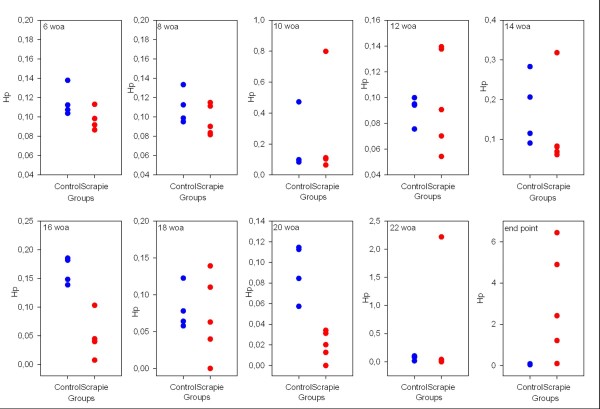
Comparison of difference in Hp levels in serum between healthy controls and scrapie infected sheep from six to 23/24 weeks of age. Scrapie (red dots), controls (blue dots), haptoglobin (Hp) levels measured in mg/ml indicated on y-axis and groups are presented on the x-axis. Each sample is individually plotted (four control samples and five scrapie samples), but, at some time points, the dots appear as one single measurement due to very similar values and the scale accommodates the scrapie measurements, as they show more variation and a higher levels.